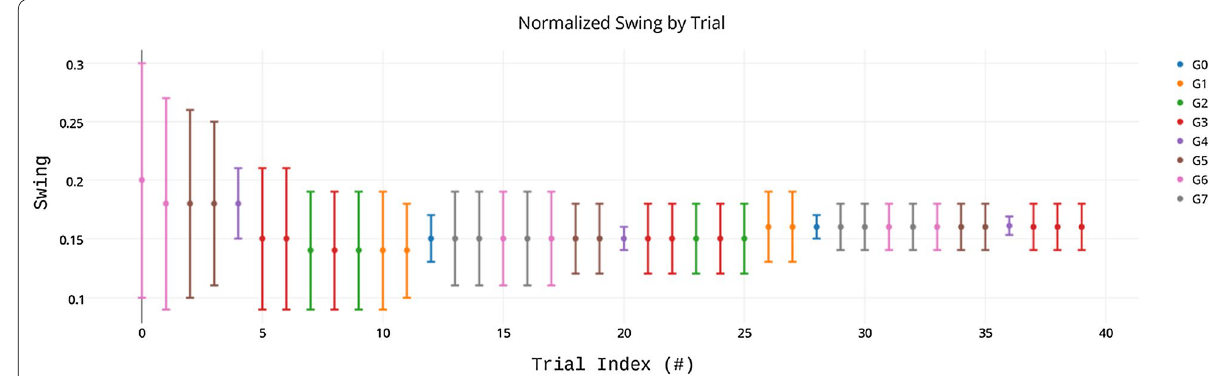
Fig. 24 Normalized swing by trial